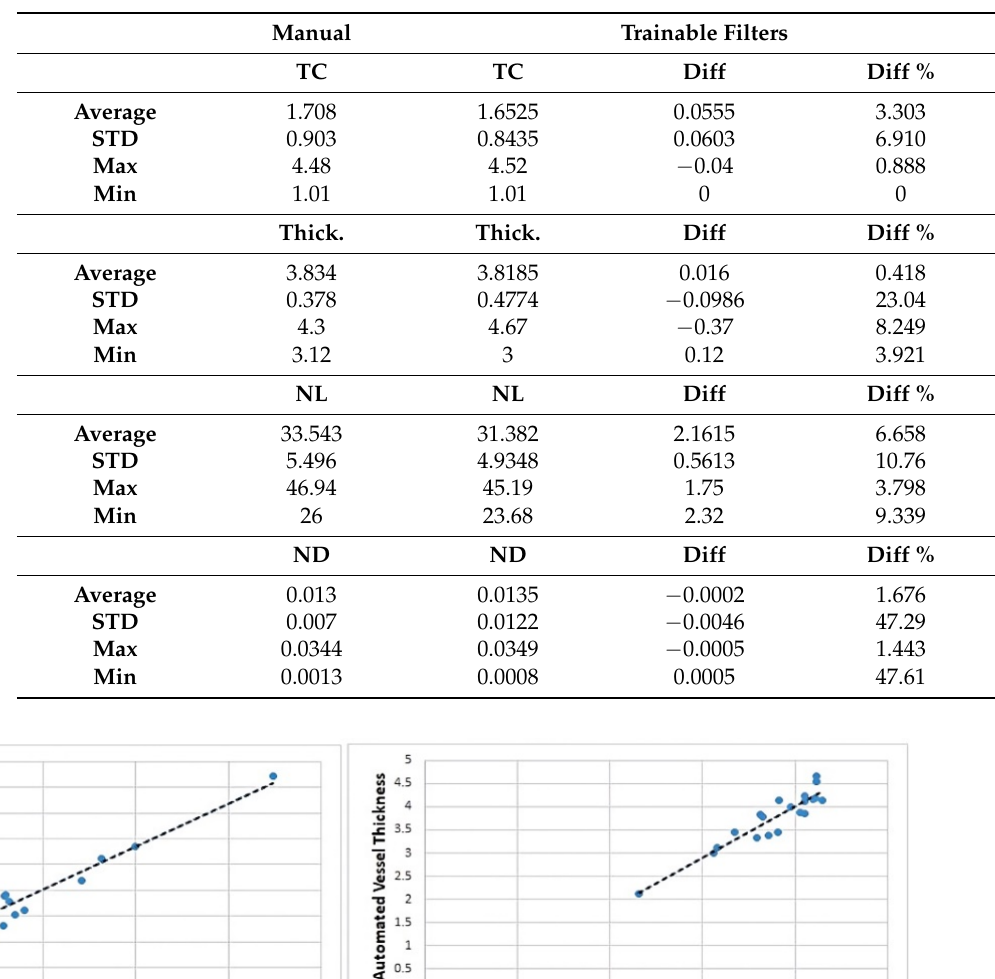
Table 6. Performance comparison conducted between the manual and automated estimations of four clinical features using the second human observer and the DRIVE dataset.